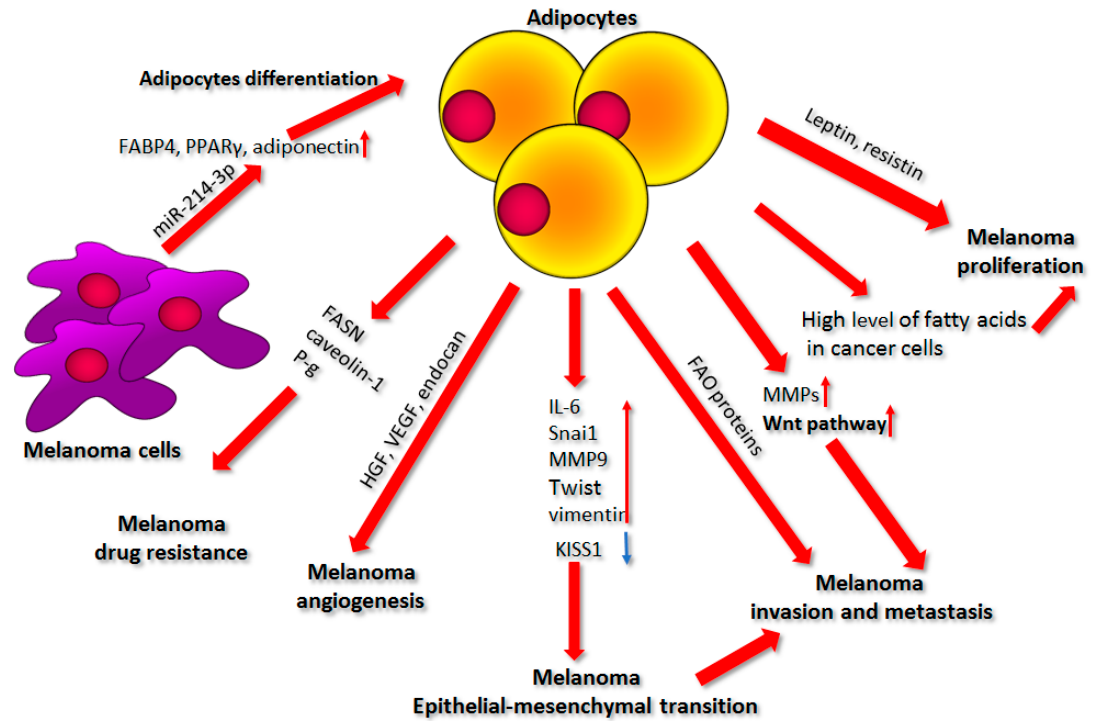
Figure 4. The influence of adipocytes on melanoma proliferation, epithelial–mesenchymal transition, cell invasion, metastasis, angiogenesis, and drug resistance. A detailed description of the shown processes is present in the text. Abbreviations: FABP4, fatty acid binding protein 4; PPARy, peroxisome proliferator-activated receptor γ ; miR-214-3p, microRNA 214-3p; FASN, fatty acid synthase; P-g, P-glycoprotein; HGF, hepatocyte growth factor; VEGF, vascular endothelial growth factor; IL-6, interleukin 6; MMP9, matrix metalloproteinases 9; FAO, fatty acid oxidation; MMPs, matrix metalloproteinases.